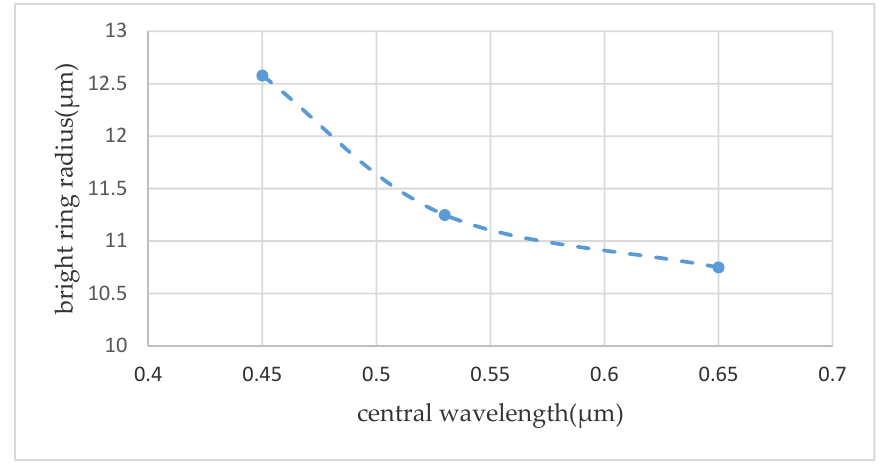
Figure 14. Relationship between the central wavelength and the radius of the bright ring.